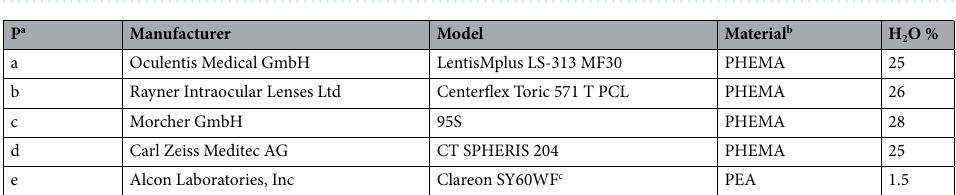
Table 1. Intraocular lens characteristics. For the IOL models LentisMplus LS-313 MF30 and CT SPHERIS 204, the manufacturers claim these IOLs to have hydrophobic surface properties. There is no precise information given on what these surface properties consist of. P = position. PHEMA = Poly (2-hydroxyethyl methacrylate). PEA = Poly (2-phenylethylacrylate). a Position in IOL holder (Fig. 1), identical for each IOL model per run. b Major material component specified. c Hydrophobic negative